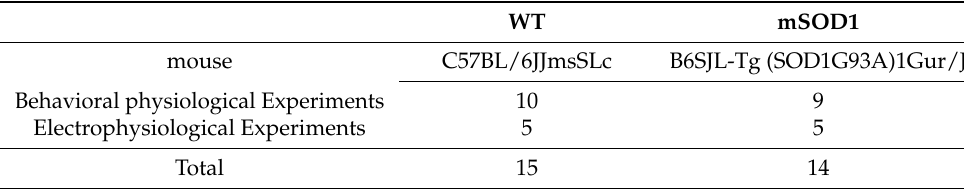
Table 1. Number of mice used in each